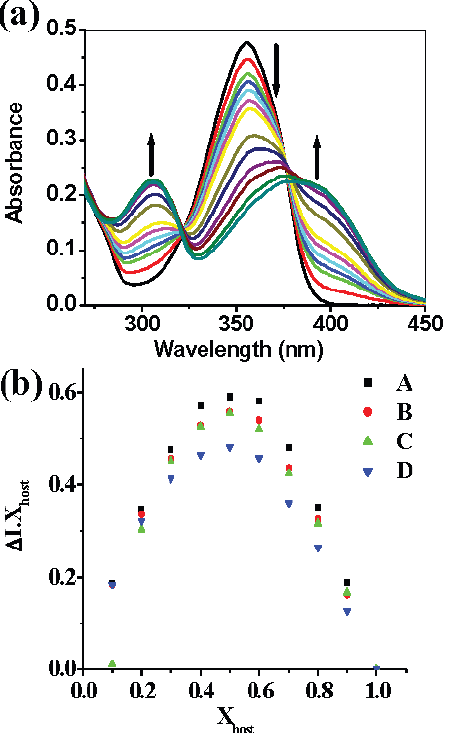
Figure 37: a) Change of absorption spectra of 36 upon addition of tetrabutylammonium pivalate in chloroform. (b) Job plots (absorbance at 356 nm) determined by UV-vis method: (A) adamantane-1-carboxylate; (B) pivalate; (C) acetate; (D) phenyl acetate.